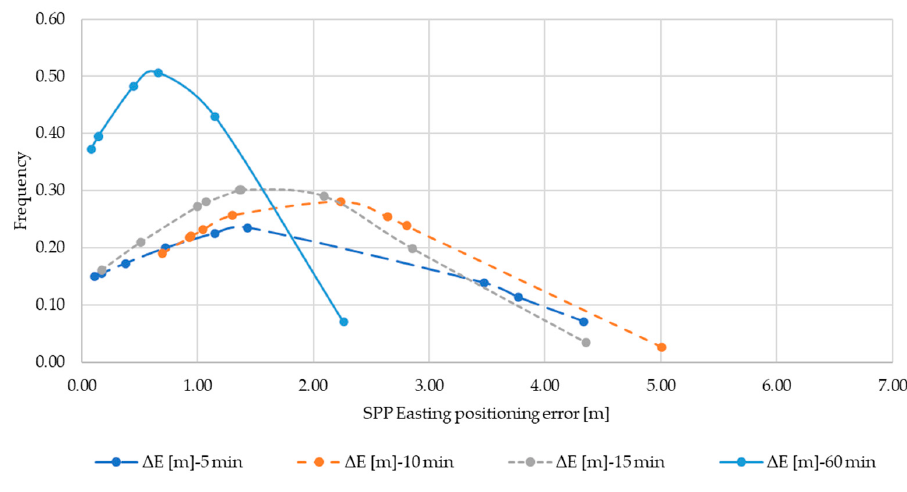
Figure A4. Normal distribution Δ E for SPP.